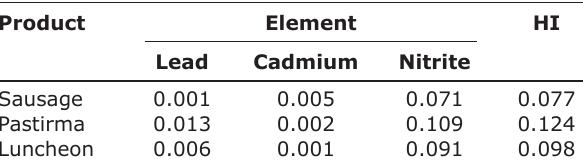
Table-6: THQ of chemical contaminants through consumption of meat